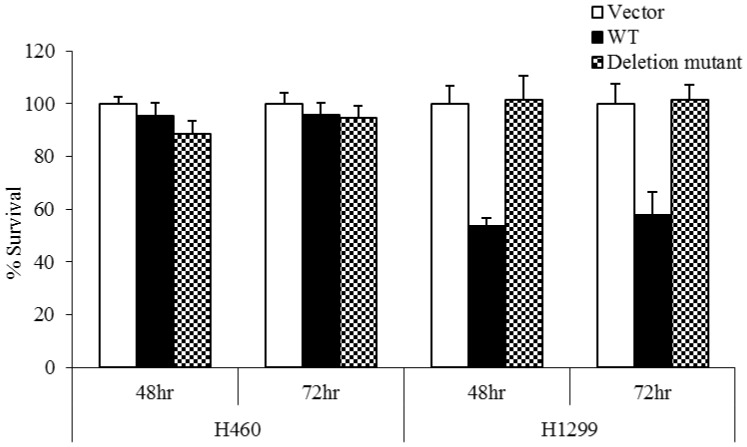
Deletion mutant fails to improve cell survival when expressed in conjunction with WT p53.48%, whereas transfection with mutant p53 resulted in over 90% survival. In H460 cells, survival was over 90% regardless of p53 mutation status, showing definitively that the novel mutation did not improve cell survival unless present as the only available form of p53, and confirming its inability to act as a dominant negative mutation.